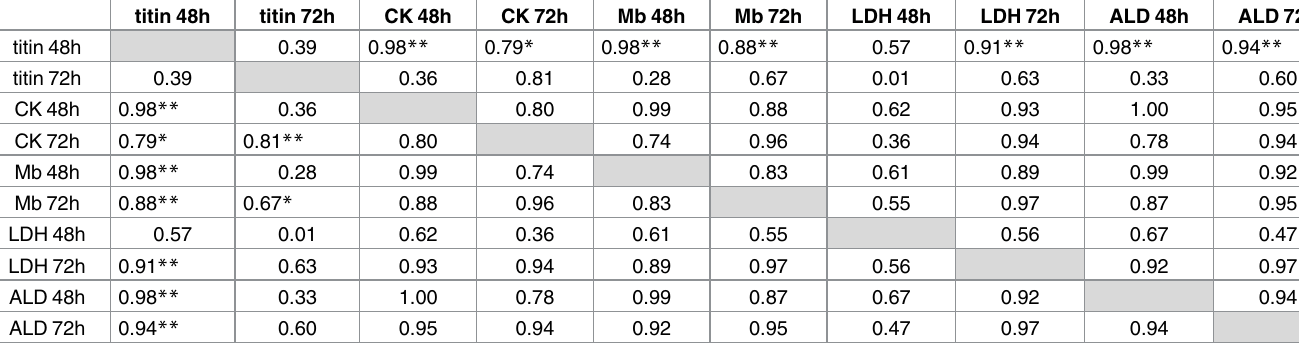
Table 2. Pearson’s correlation coeffcient matrix of titin and muscle damage